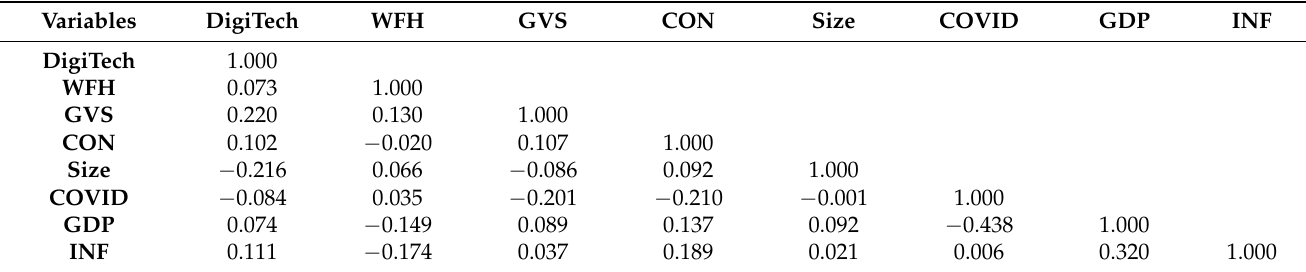
Table 5. Cross-correlation